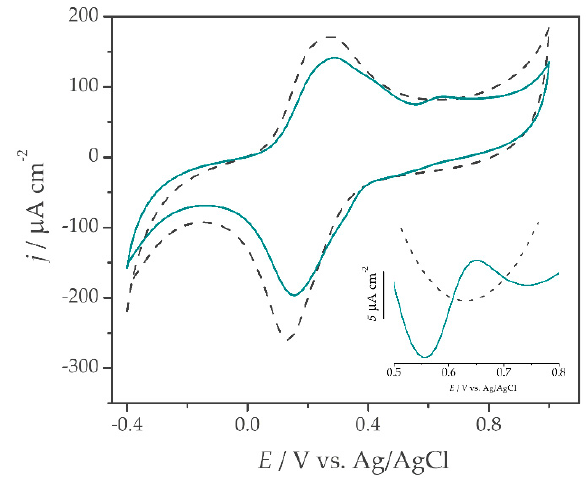
Figure 1. Cyclic voltammograms (CVs) ( v = 50 mV s − 1 ) recorded in 0.1 M KCl + 5 mM HCl with PMB DES /GCE (dotted black) and in the presence of 100.0 µM 5-aminosalicylic acid (5-ASA) (green). Inset, magnification of the cyclic voltammetry (CV) curves at the onset potential region of the 5-ASA oxidation.